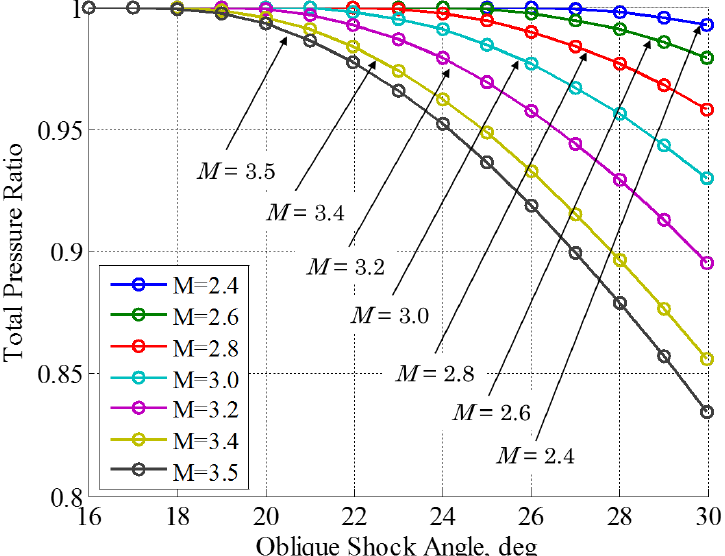
Figure 10. Total pressure ratios across an oblique shock wave for various Mach numbers.